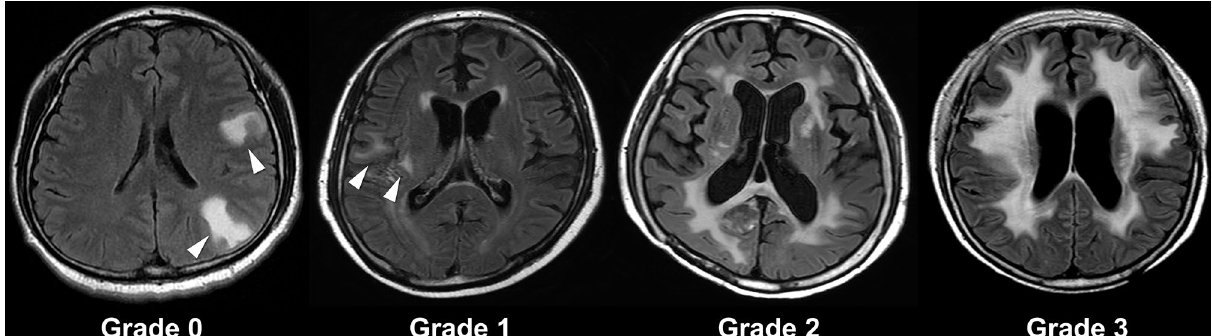
Figure 3. Fluid attenuation inversion recovery (FLAIR) images showing the white matter signal change. Radiation-induced leukoenchepalopathy (RIL) is classified into four grades using the grading system 34 . Tumor- related edema is not regarded as the RIL (white